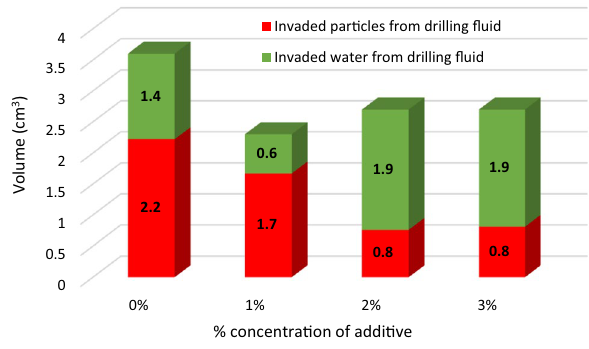
Fig. 13 Volume of invaded solid particles and water as a function of additive concentration